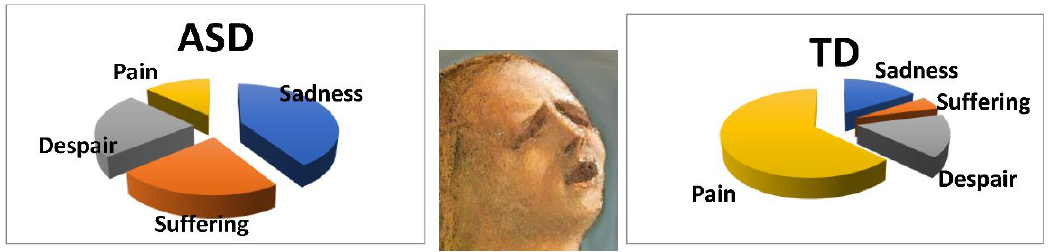
Figure 9. Different emotions attributed to image 9a (in the middle) by ASDs ( left ) and TDs ( right ).